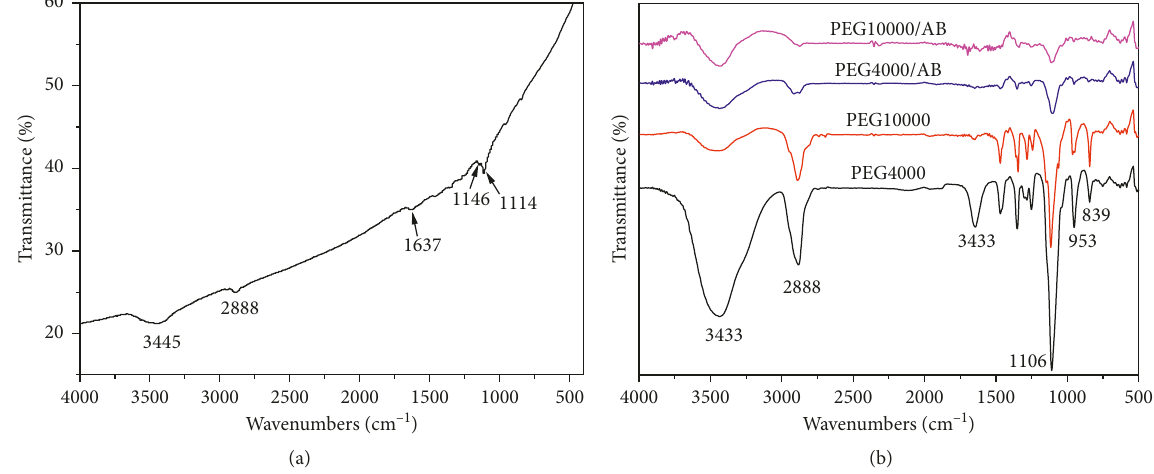
Figure 1: FTIR spectrums of the AB particles (a) and PEG/AB composites (b).